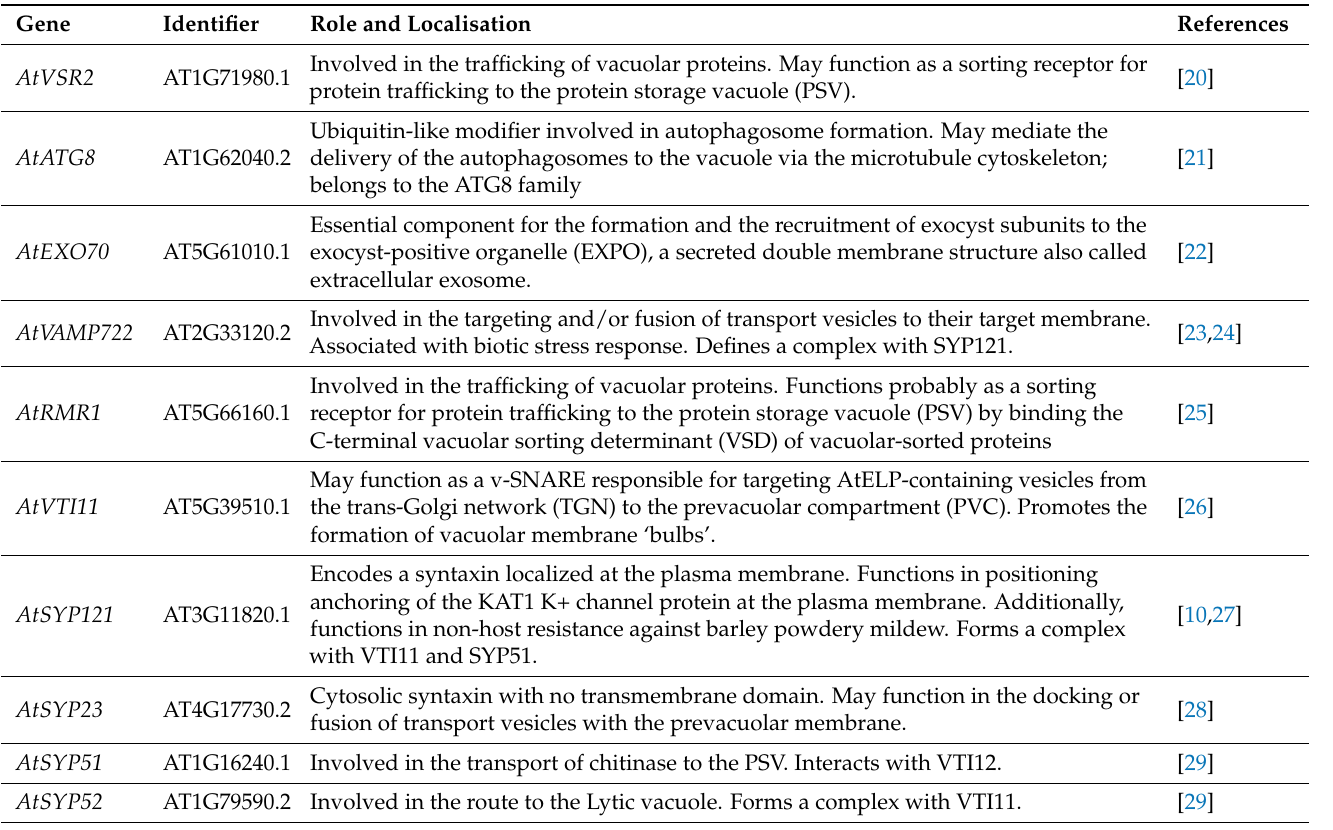
Table 1. Endomembrane-related genes used in this